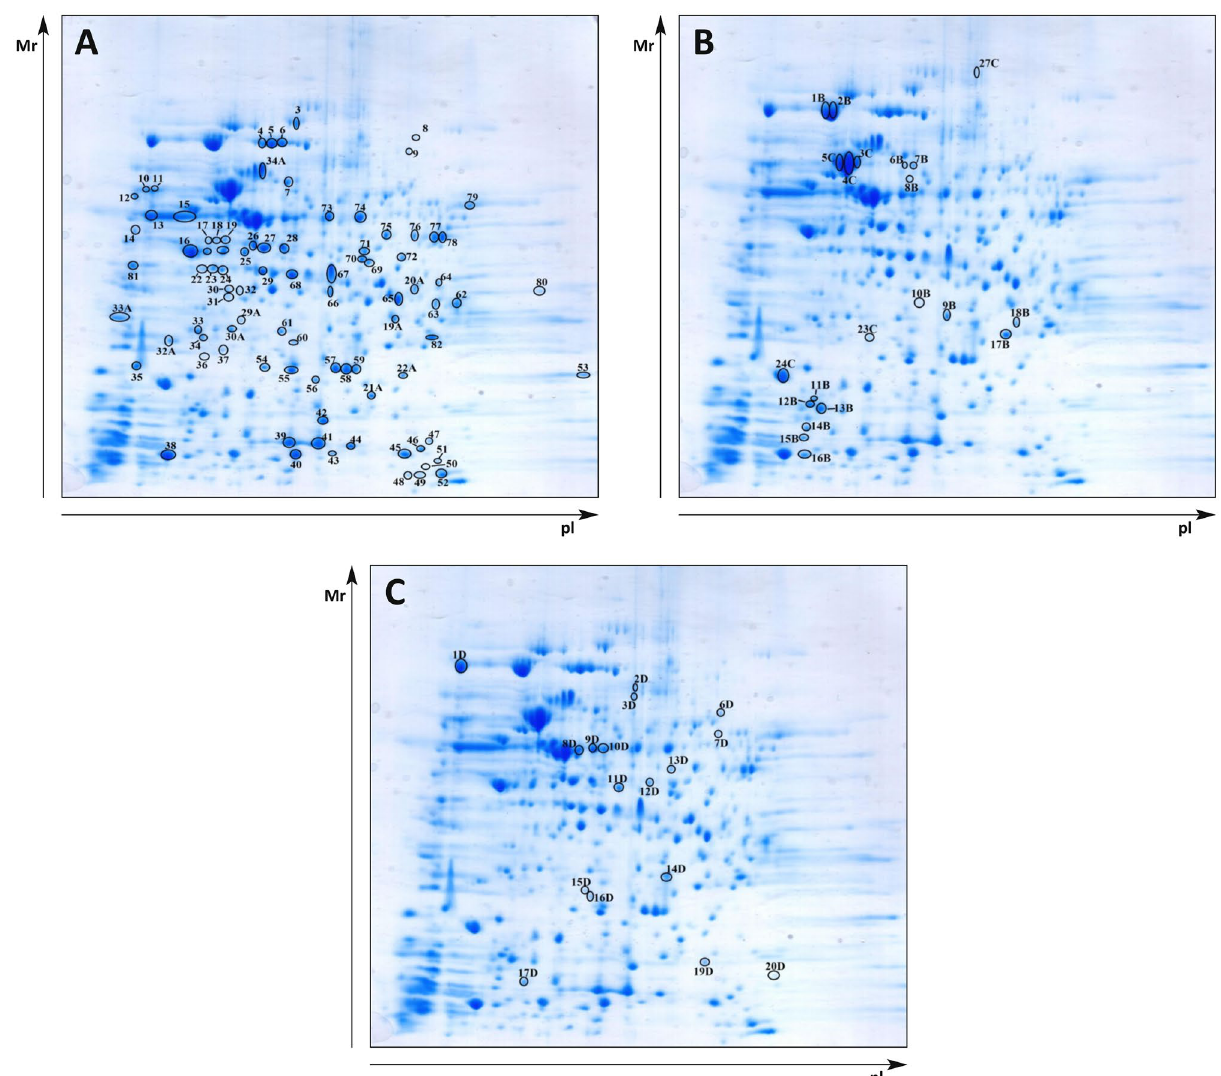
Figure 4. The 2-D reference gels of F. tularensis FSC200 whole-cell lysate protein targets, which are recognized by sera from F. tularensis FSC200 infected Balb/c GF mice. ( a ) The targets of Balb/c GF mice antibody response 150 μg of protein was separated by immobilized pH gradient (IPG) strips (3–10) and 12% (w/v) SDS-PAGE gels. Identified immunogenic protein spots were numbered in preparative 2-D SDS-PAGE gels, excised for MS/MS analysis, corresponding to the proteins in Table S1 (designated letters and numbers of protein spots were used only for internal purposes and do not necessarily imply the same identity of the labeled proteins). Polyclonal peroxidase-conjugated goat anti-mouse IgG antibody was used for secondary antibody detection. All experiments were performed in biological triplicates (individual sera) for all time intervals and were independently repeated at least three